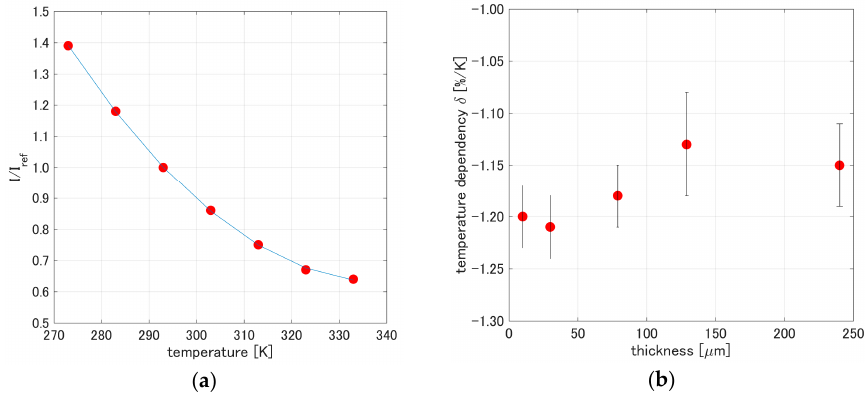
Figure 7. ( a ) Temperature calibration of PCPSP th 01 ; ( b ) Temperature dependency related to PC-PSP thickness.